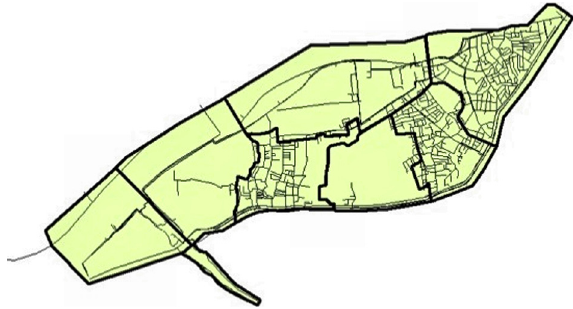
Fig. 4. Water pipe network and zones – City of